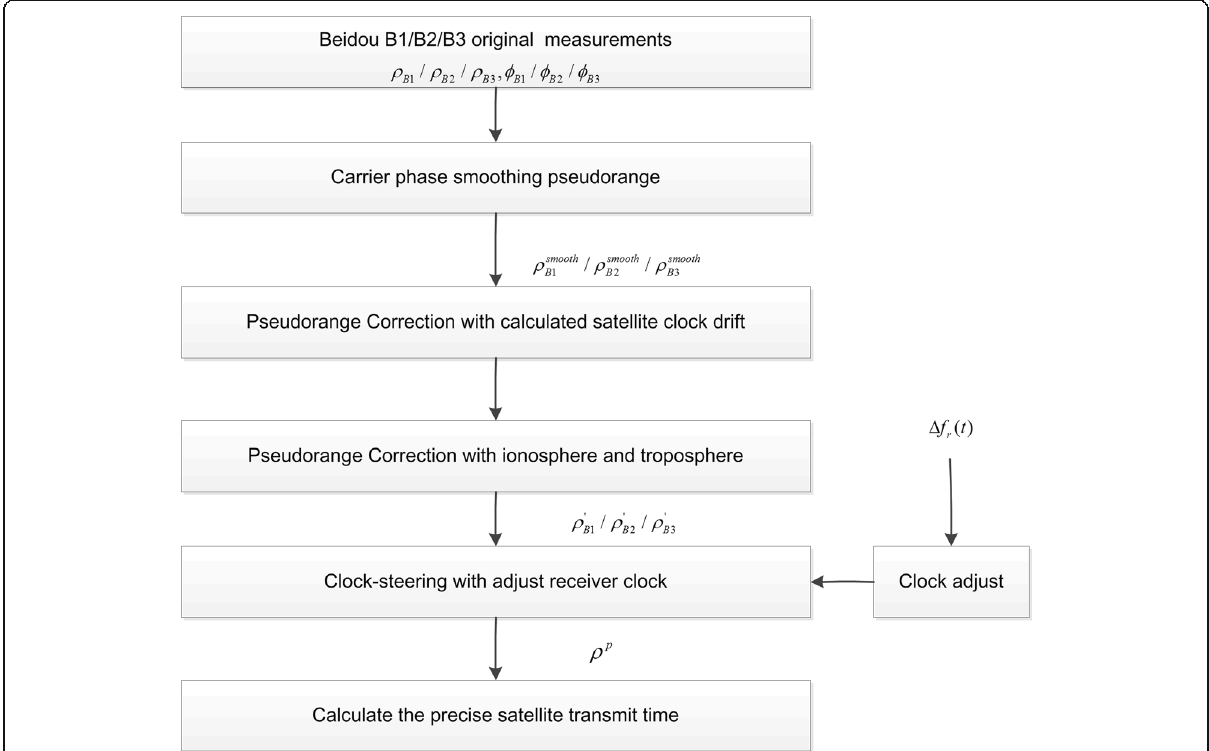
Fig. 6 Block diagram of the time transfer process flowchart between MCS and